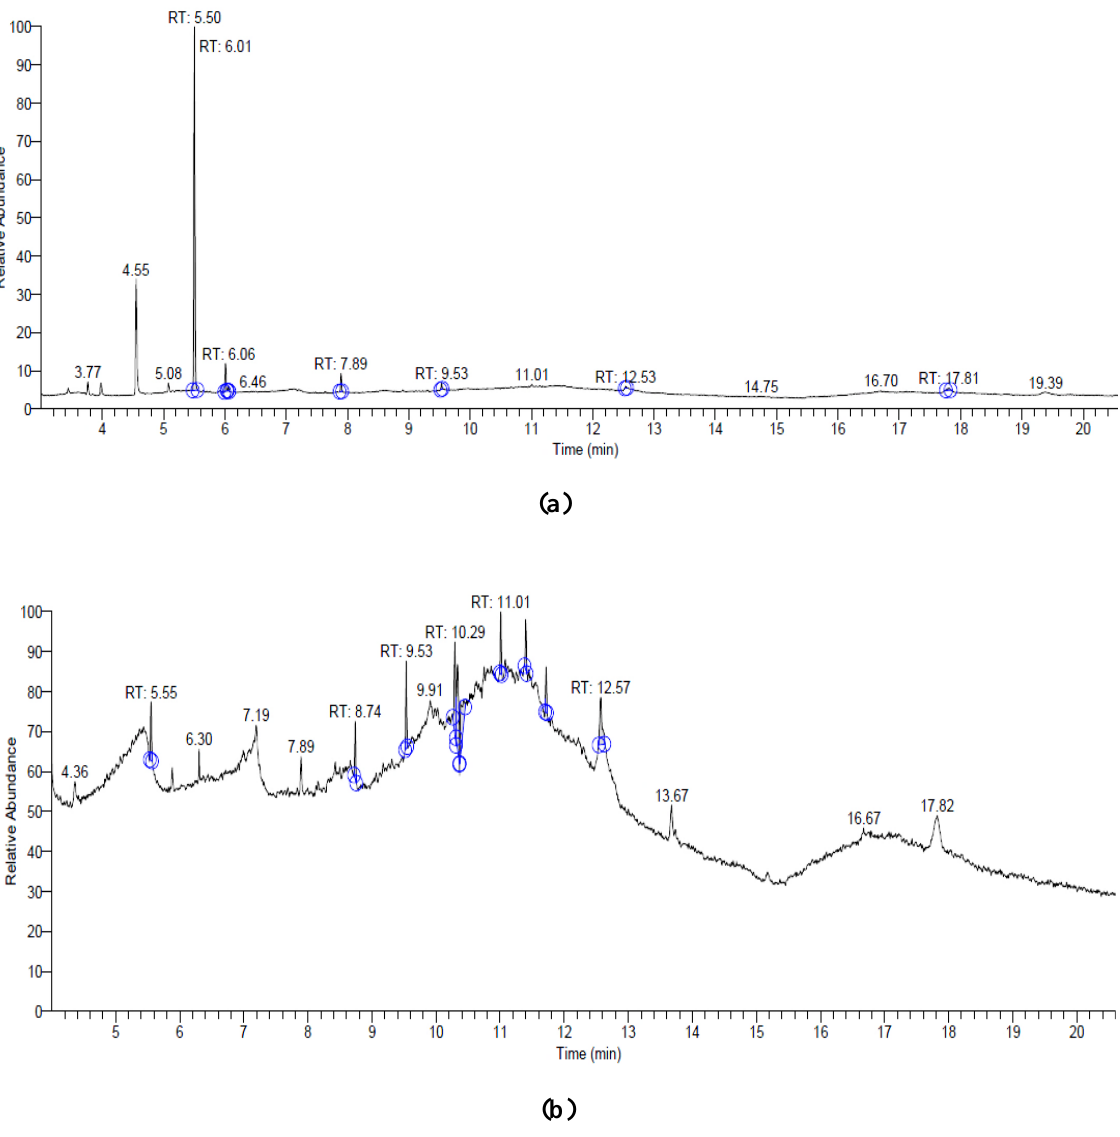
Figure 5. GCMS chromatogram of secondary metabolites produced by Porostereum sp. HGBS16 and Neurospora sp.